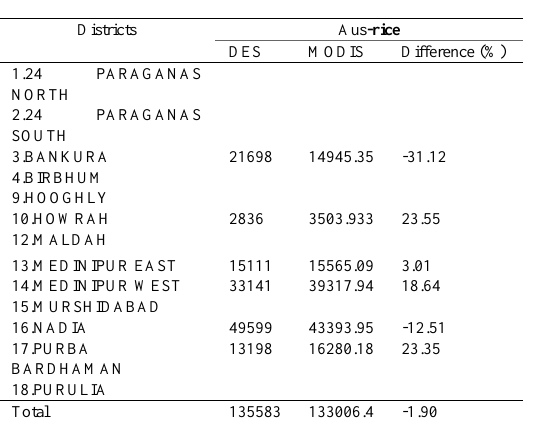
Table 2. Comparison between DES and MODIS rice area